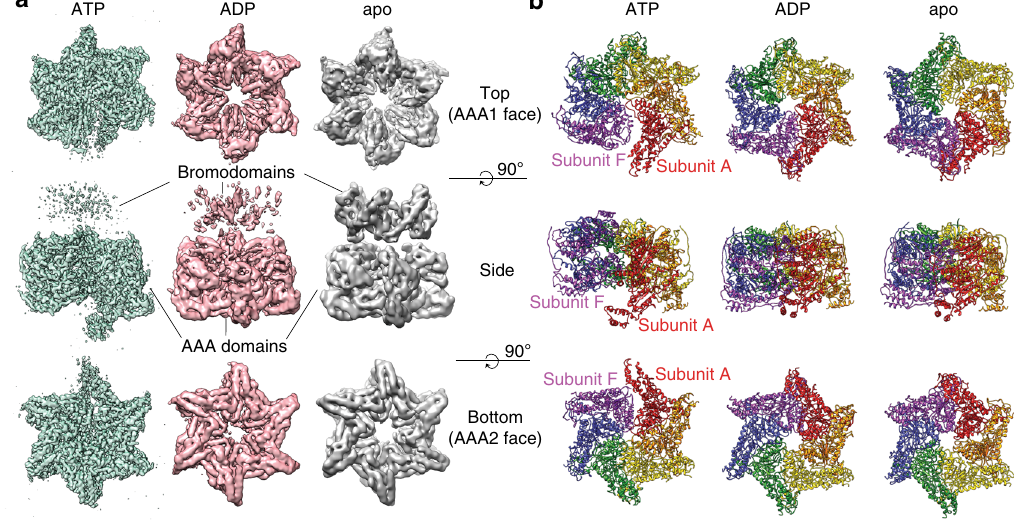
Fig. 4 Comparison of Abo1 cryo-EM structures in the ATP and ADP states reveal a hexameric spiral-to-ring transition. a Cryo-EM maps of Abo1 in the ATP, ADP, and apo states showing the “ top ” (AAA1), “ side ” , and “ bottom ” (AAA2) face of the AAA + hexamer. Resolution of ATP, ADP, and apo structures are at 3.5 Å, 4.4 Å, and 6.9 Å respectively. Electron density above the AAA + ring is assigned as the bromodomain. The top view is clipped underneath the bromodomain to show the upper surface of the AAA1 domains. A top view of the apo-Abo1 bromodomain is shown in Supplementary Fig. 12. b Structures of Abo1 in the ATP state, and fl exible- fi tted Abo1 models in the ADP and apo state. The Abo1 hexamer is colored according to subunit (chains A –